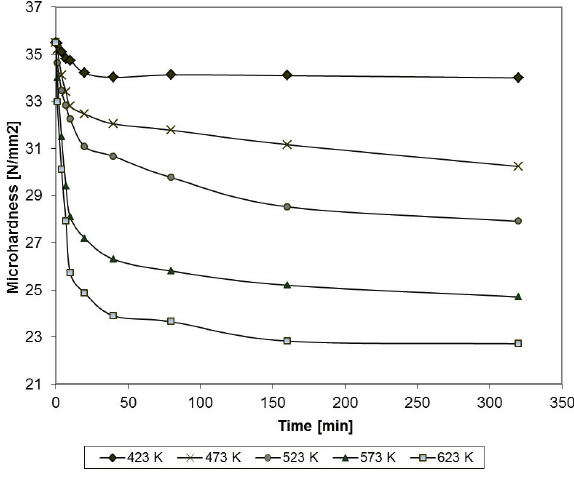
Figure 3. Diagram showing the influence of annealing time and temperature on the microhardness of the alloy